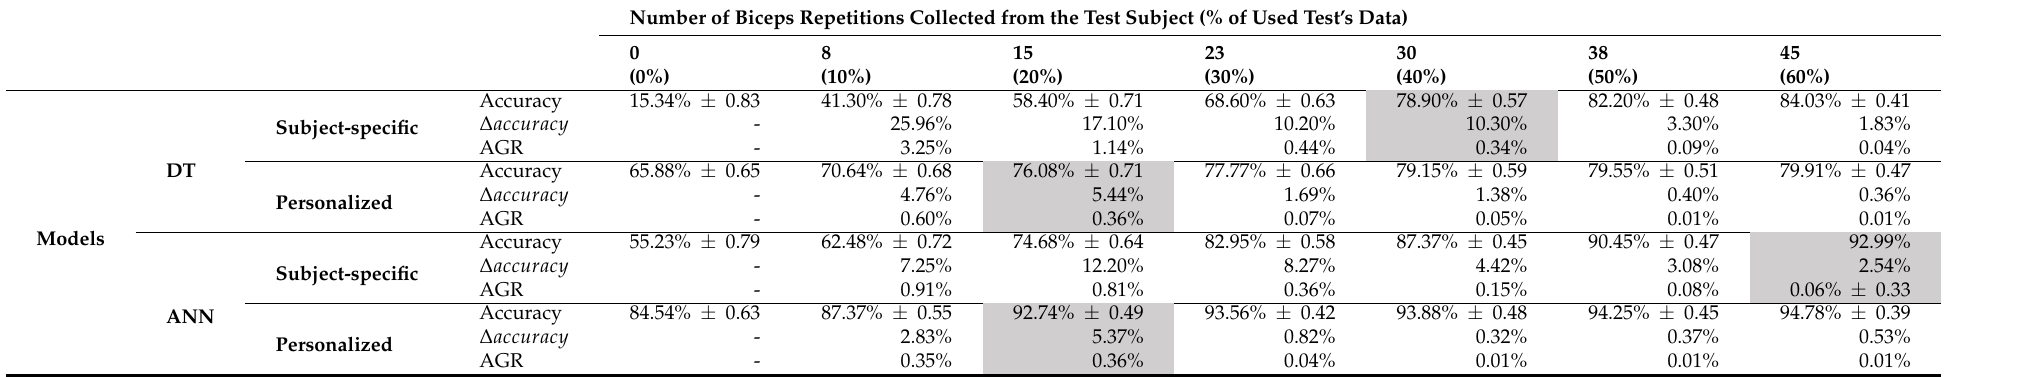
Table A1. The accuracy averages for the subject-specific and personalized models after adding 10% of the test subject’s data to the training set in each run incrementally. Number of Biceps Repetitions Collected from the Test Subject (% of Used Test’s